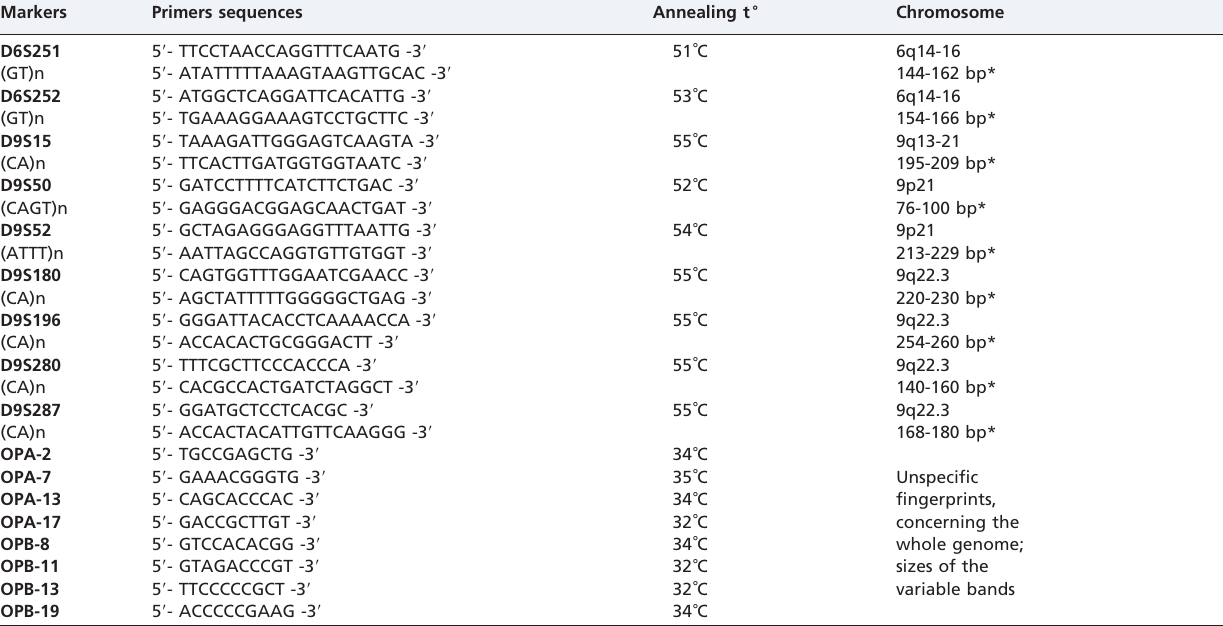
Table 1 – The RAPDs and microsatellites studied, including the primer sequences, PCR annealing temperatures, chromosomal locations and polymorphism ranges in base pairs